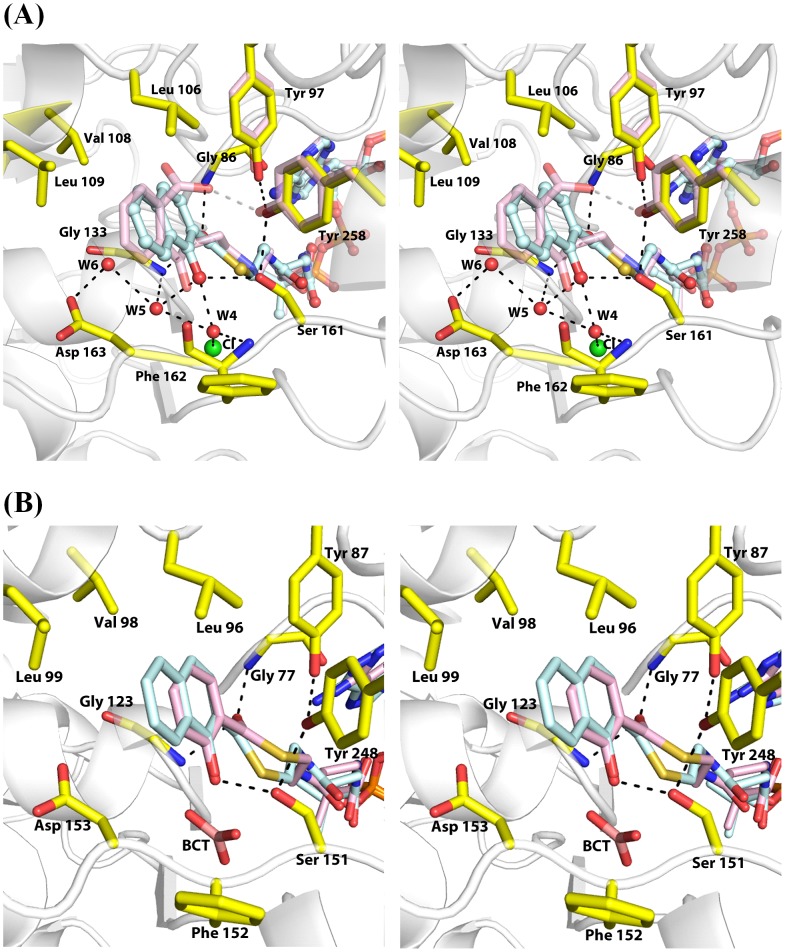
Interactions between the acyl moiety of the ligands and active site residues in ecMenB (A) and scMenB (B) complexes.Side chains of the conserved active site residues are shown in sticks with carbon atom colored yellow. Water molecules are shown in red spheres and chloride anion is shown in green sphere. Dashed lines indicate potential hydrogen bonds with a distance less than 3.5 Å. In (A), the protein structure of ecMenB: HNA-CoA is represented in gray cartoon and HNA-CoA is represented as sticks with C, O, N, S and P atoms colored light blue, red, blue, brown and orange, respectively. The substrate analog OSB-NCoA and the side chains of Tyr-258 and Tyr-97 from the ecMenB: OSB-NCoA structure (PDB code: 3T88) are superimposed onto the ecMenB:HNA-CoA structure and shown with all carbon atoms colored in pink. In (B), the protein structure of scMenB: SA-CoA is represented in gray cartoon and the ligands SA-CoA and bicarbonate are represented as sticks with C, O, N, S and P atoms colored pink, red, blue, brown and orange, respectively. HNA-CoA from the scMenB:HNA-CoA structure is superimposed onto the scMenB:SA-CoA structure and shown with all carbon atoms colored in light blue.